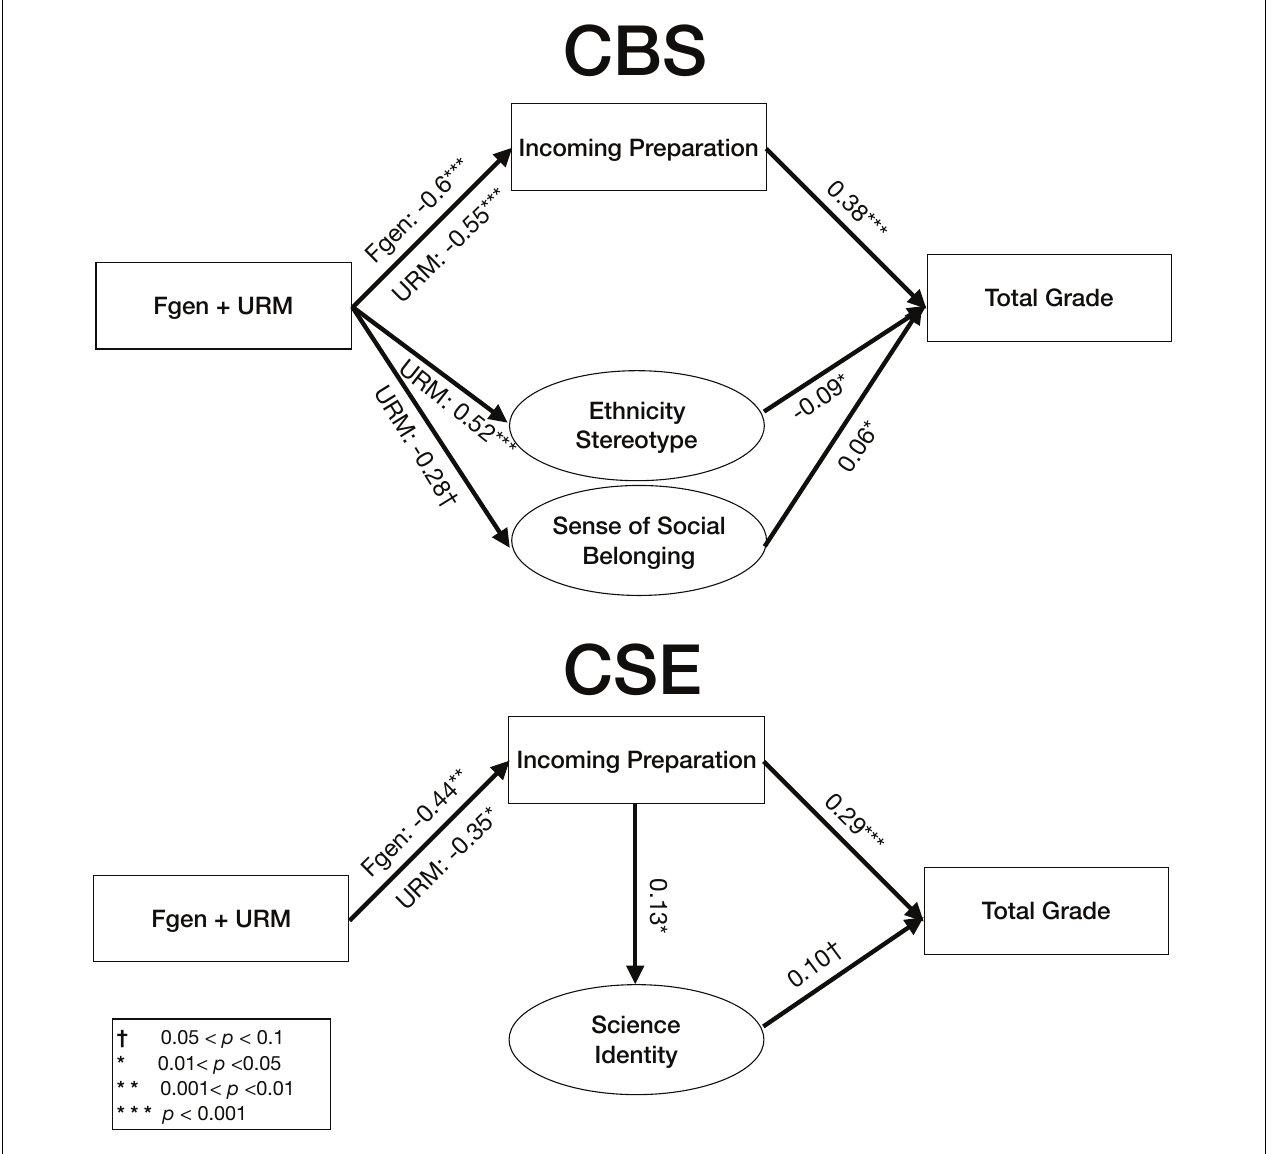
FIGURE 6 | Significant mediation paths between demographic status, incoming preparation, social psychological factors, and student total grades in multiple introductory science classes across the College of Biological Sciences (CBS) and the College of Science & Engineering (CSE). The numbers represent coefficients in standard deviation